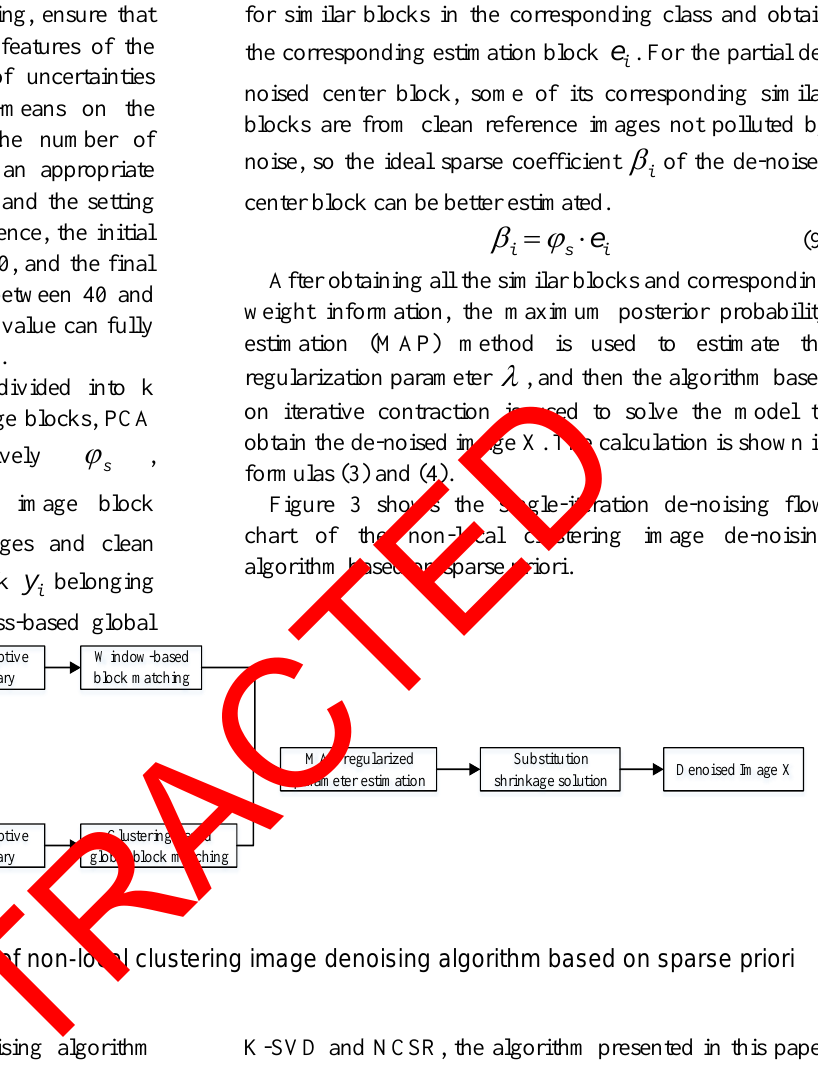
Figure 3. Single iteration flow chart of non-local clustering image denoising algorithm based on sparse